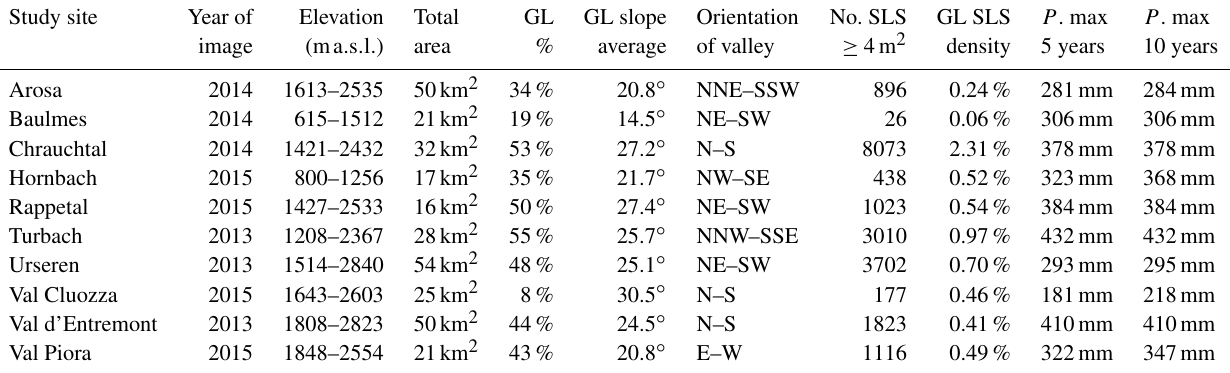
Table 1. List of study sites and descriptive information: elevation range, total area of the study site, grassland area within study site in per cent, average slope of grassland area, orientation of the main valley axis, number of shallow landslides and shallow-landslide density in grassland areas. The max precipitation events (monthly values) of the previous 5 and 10 years are averaged over the study site. Note that both time spans might include the same events. GL: grassland; SLS: shallow landslides; P : precipitation. Study site GL